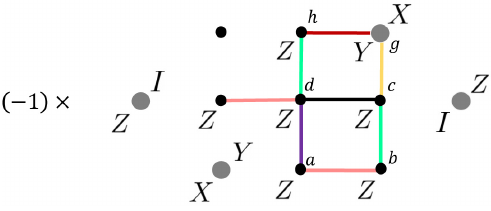
FIG. 27. The stabilizer acts on the vertex d that connects to pink, black, purple, and green edges. This stabilizer comes from identity (C5) for a closed loop a → b → c → d → a . The ˜ product of A e on any closed loop is generated by this